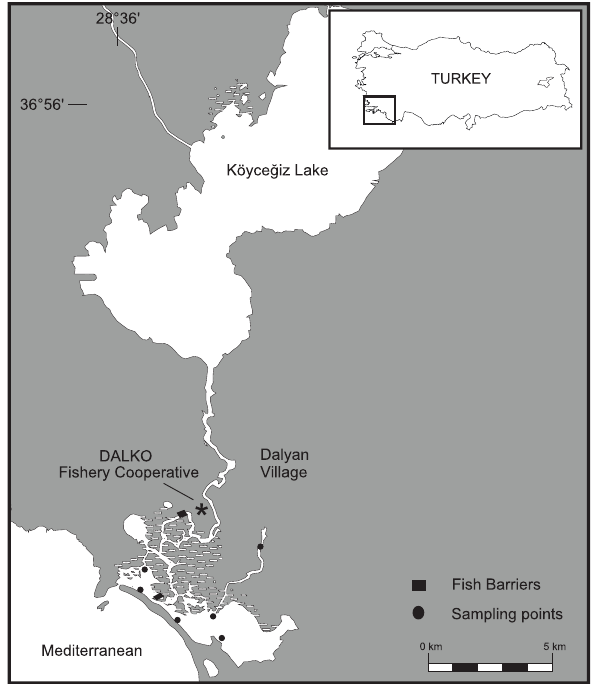
Fig. 1. Sampling points of Köyceğiz Lagoon,